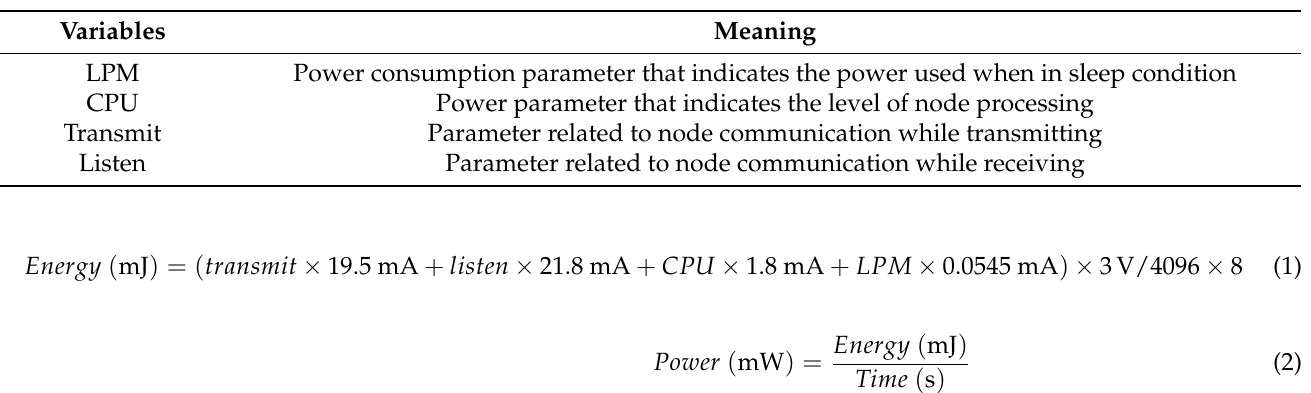
Table 2. Equation parameters